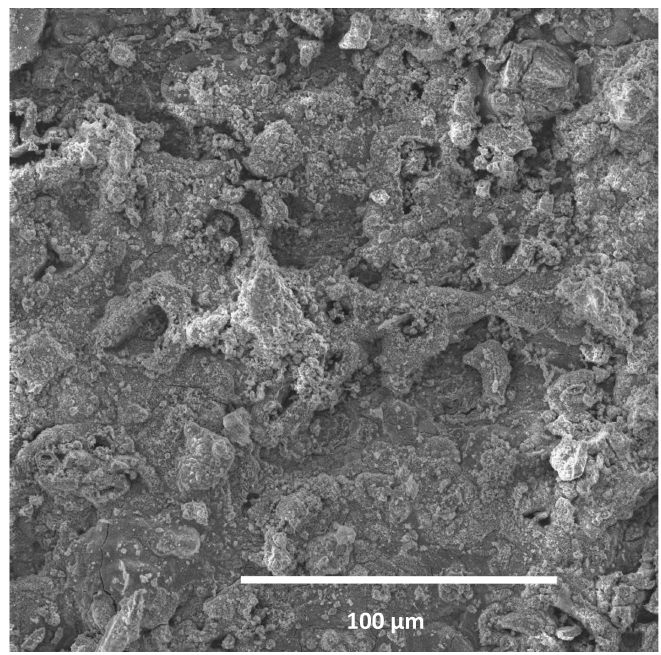
Figure 6. Cross section of L80-1 sample exposed to 95 ◦ C corrosion scale (a long sample). On metallographic microsections, transverse to the surface (Figure 6), the microstruc- ture of the steel substrate of a sample fragment and a layer of corrosion products are visible. In the upper part, apart from visible pits, there is a black layer of corrosion products. The layer is porous, uneven, and cracked. The corrosive medium has access to the steel substrate via the unevenness, pores, and cracks. White inclusions are visible in certain places; this is a precipitated salt crystal, which integrated into the corrosion scale (Table 4). The majority of the studied sample is covered with scale, uniform corrosion, and single deep pits, 40 to 65 µ m deep, visible under the microscope (Figure 7).